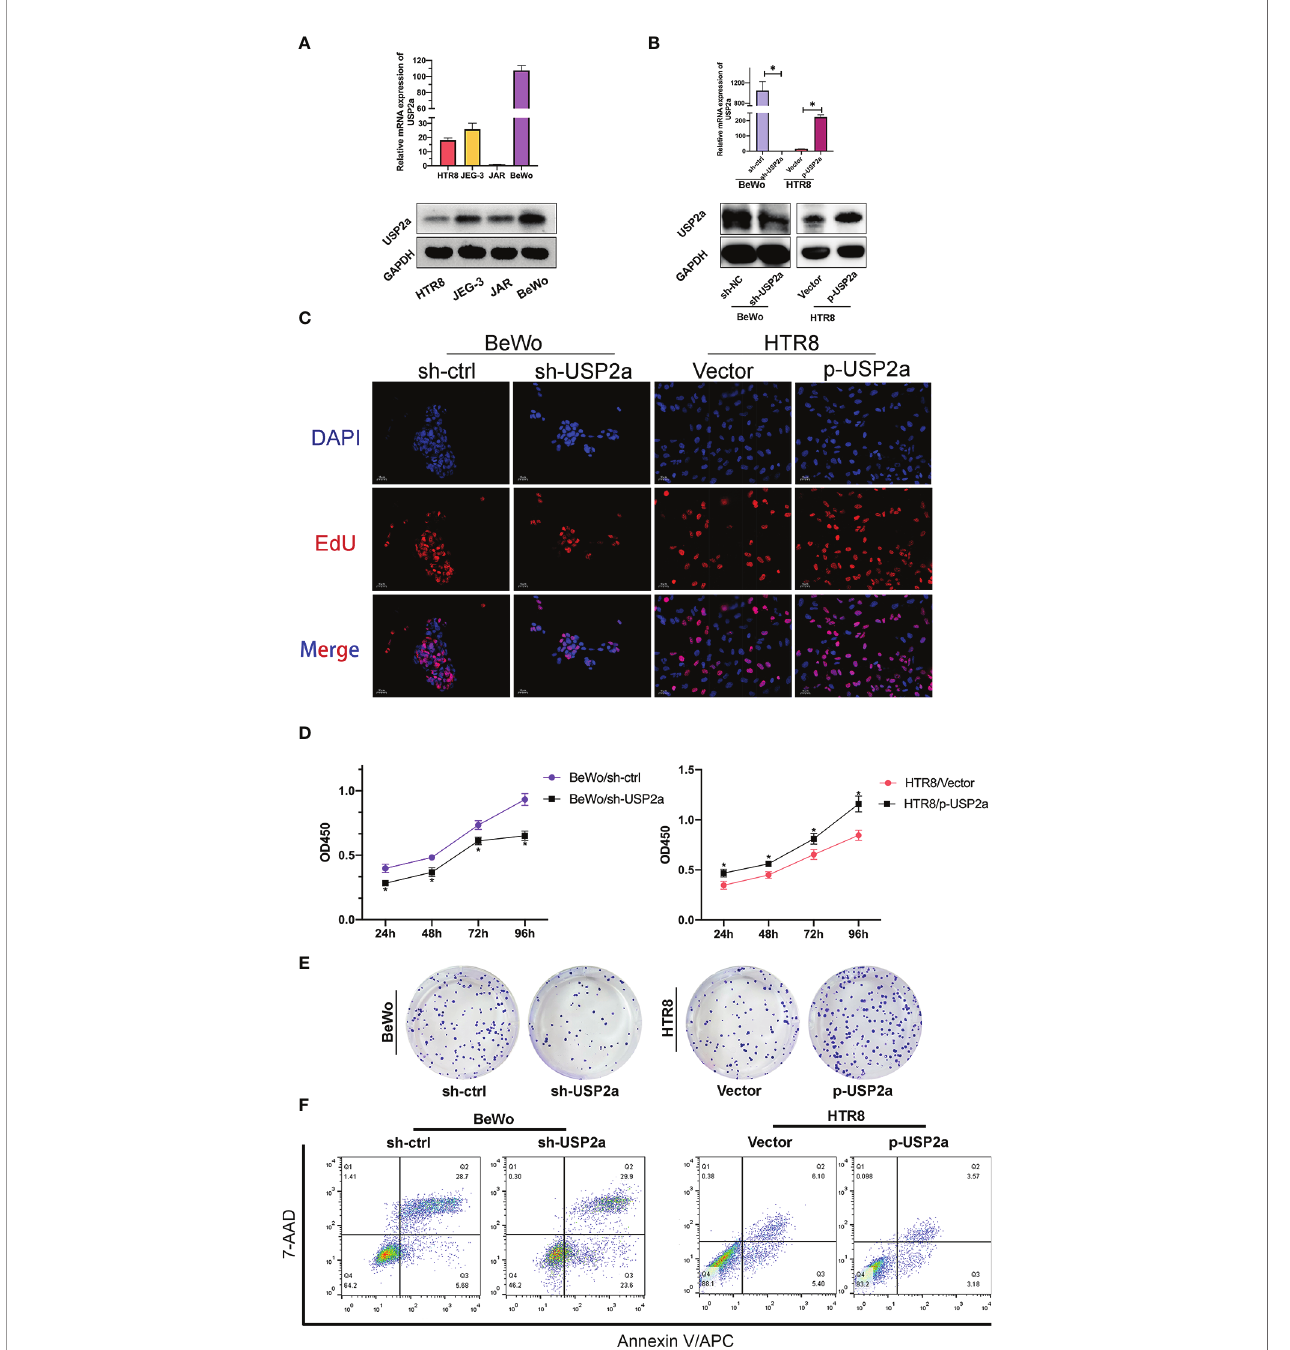
FIGURE 2 | USP2a promoted human trophoblast ‐ derived cell lines proliferation and inhibited cell apoptosis in vitro . (A) Relative USP2a mRNA and protein expression levels in four human trophoblast ‐ derived cell lines were measured by RT ‐ PCR and western blot, respectively. GAPDH was used as the loading control. (B) Knockdown of USP2a by shRNA (sh ‐ USP2a) and upregulation of USP2a by plasmid expression were conducted in the BeWo and HTR8 cell lines. The mRNA expression and protein level of USP2a were con fi rmed by RT ‐ PCR and western blot. (C) Representative images of EdU labeling assay in p-USP2a/HTR8 and sh- USP2a/BeWo. DAPI staining blue; EdU staining red. Scale bar = 10 m m (D) Cell proliferation was measured 48 hours after transfection using the CCK8 assay. (E) Knocking down USP2a inhibits cell clone formation signi fi cantly in BeWo cells. Overexpression of USP2a promotes cell clone formation in HTR8 cells. (F) Quantitative fl ow cytometry measurements of apoptosis in trophoblast cell lines after transfection of either p-USP2a or shRNA. The percentage of live (7AAD − /Annexin V − ), early apoptotic (7AAD − /Annexin V+), and dead (7AAD+/Annexin V+) cells was determined. * P <